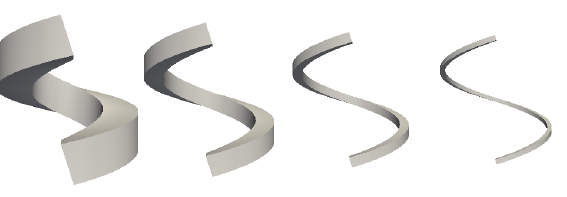
Figure 5. Helicoidal spring geometry for different thickness/length ratios: 0.1, 0.05, 0.025,